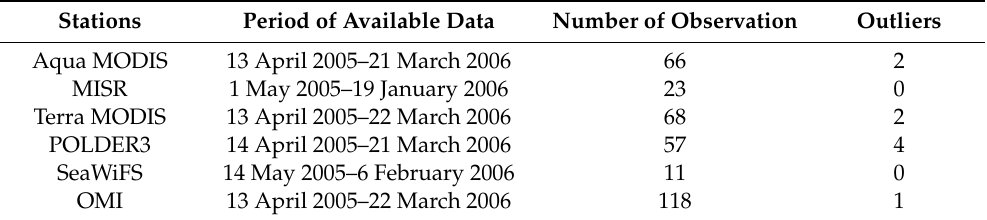
Table 1. The spaceborne sensors validated against observations of the Egyptian Meteorological Authority (EMA) station. MODIS: Moderate Resolution Imaging Spectroradiometer, MISR: Multi-angle Imaging Spectroradiometer, POLDER3: POLarization and Directionality of the Earth’s Reflectances, SeaWiFS: Sea-viewing Wide Field-of-view Sensor, OMI: Ozone Monitoring